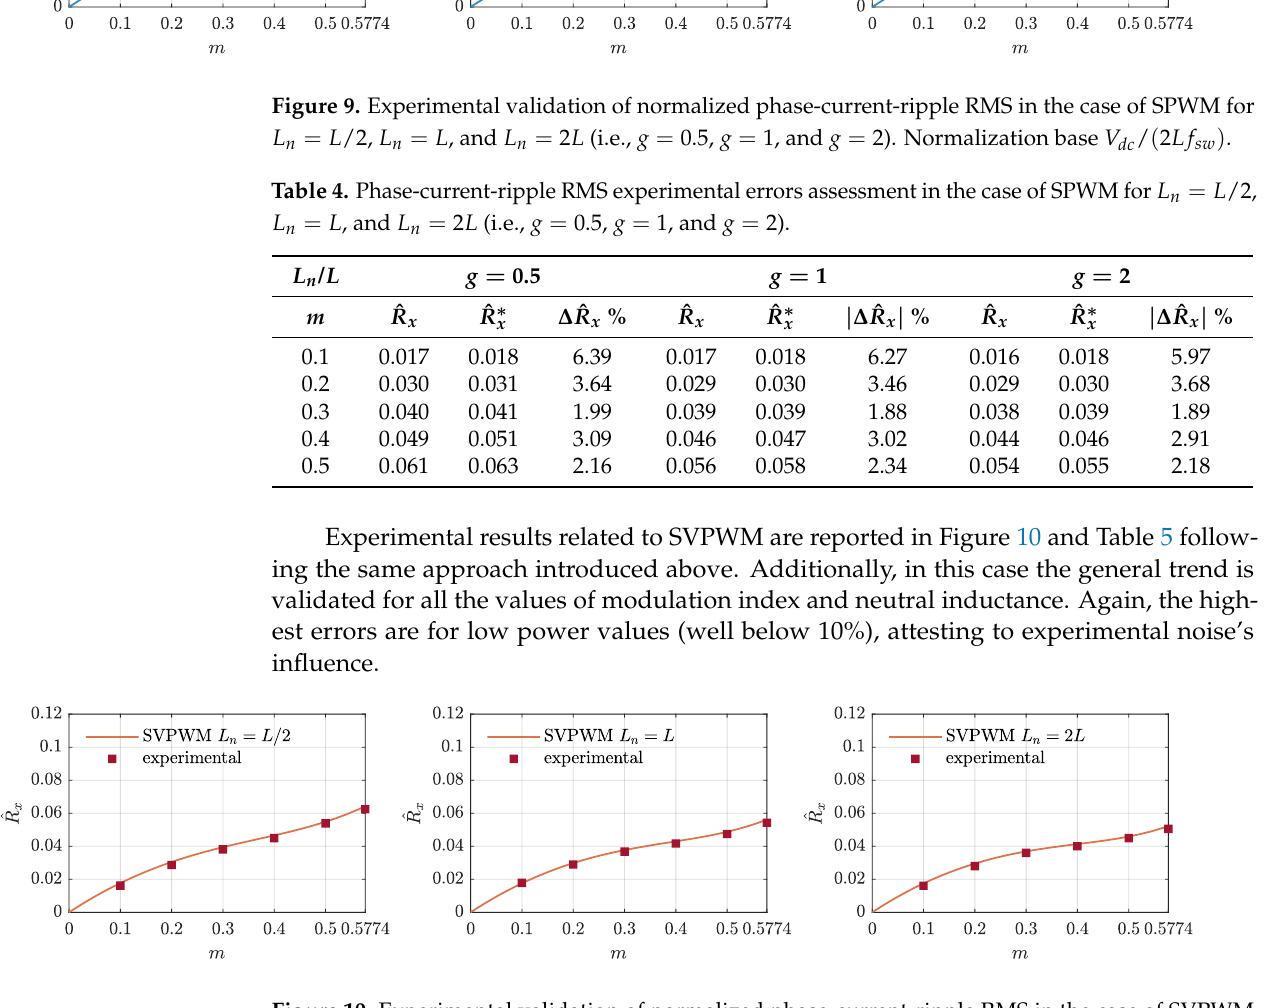
Figure 10. Experimental validation of normalized phase-current-ripple RMS in the case of SVPWM for L n = L /2, L n = L , and L n = 2 L (i.e., g = 0.5, g = 1, and g = 2). Normalization base V dc / ( 2 Lf sw ) . Table 5. Phase-current-ripple RMS experimental errors assessment in the case of SVPWM for L n = L /2, L n = L , and L n = 2 L (i.e., g = 0.5, g = 1, and g =